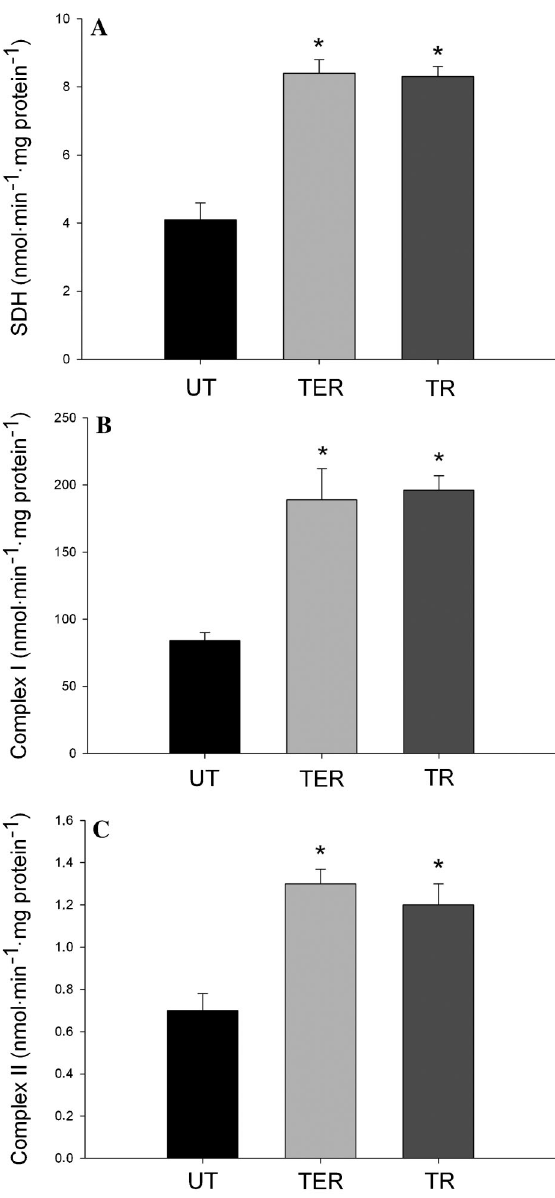
Figure 1. Mitochondrial respiratory chain enzyme activities [succinate dehydrogenase (SDH) ( A ), complex I ( B ), and complex II ( C )] were determined in skeletal muscle 48 h after the last session of training. The animals were divided into 3 groups (N = 6 each): UT = untrained; TER = trained eccentric running (16 ˚ ); TR = trained running (0 ˚ ). Data are reported as means ± SE. *P , 0.05 compared to the UT group (Tukey HSD test).